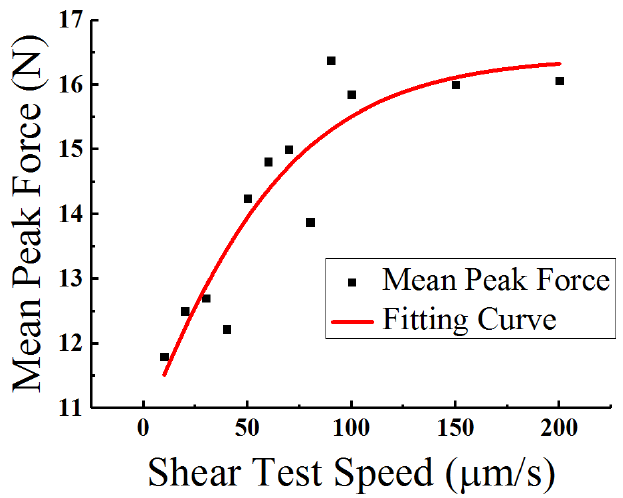
Figure 5. The mean peak force values for all twelve speeds, with fitting curve.